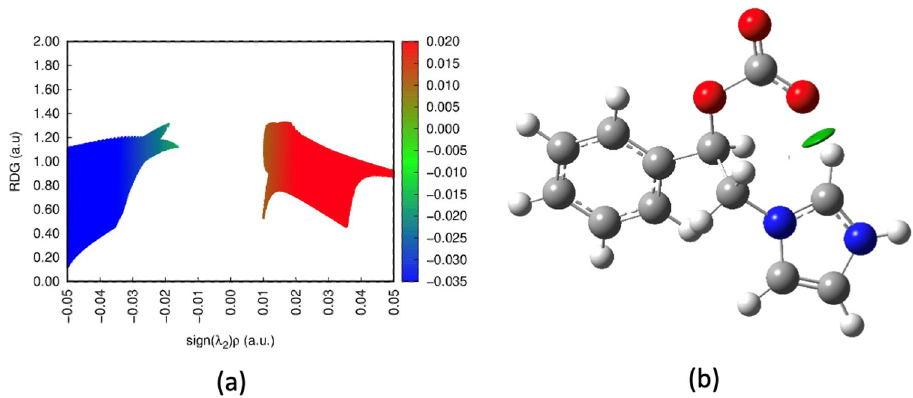
Figure 5. ( a ) RDG scatter graph for imidazole. ( b ) Visual representation of NCI interactions in imidazole (green).